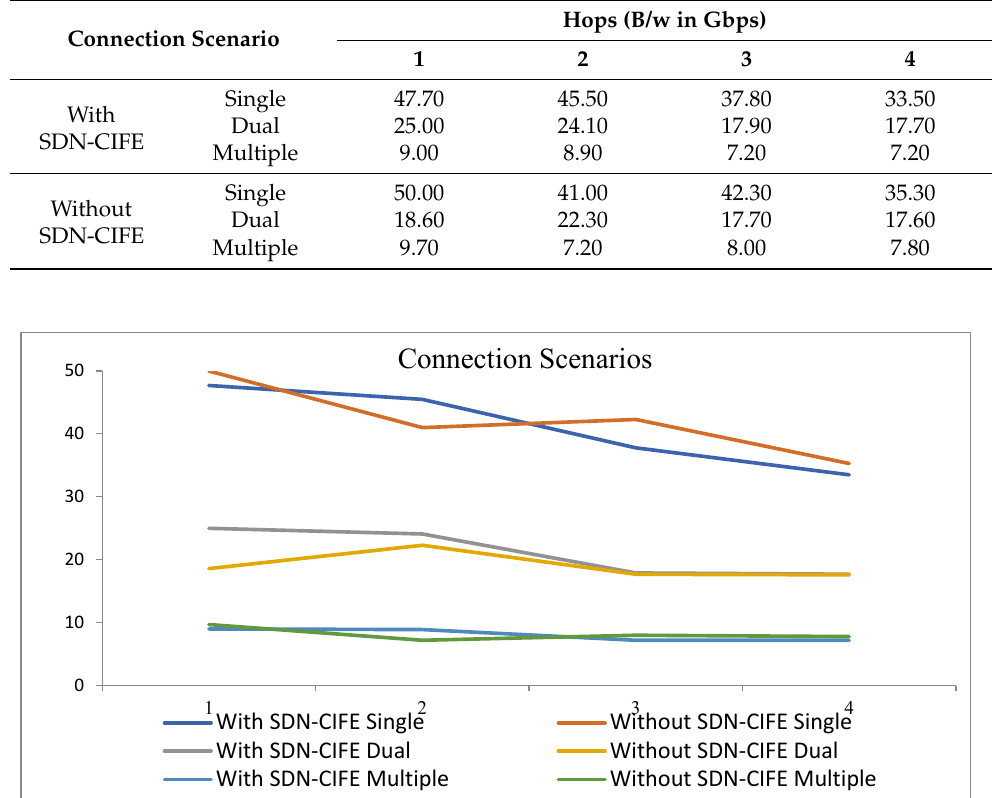
Figure 7. Bandwidth Delivery Test for H3S.